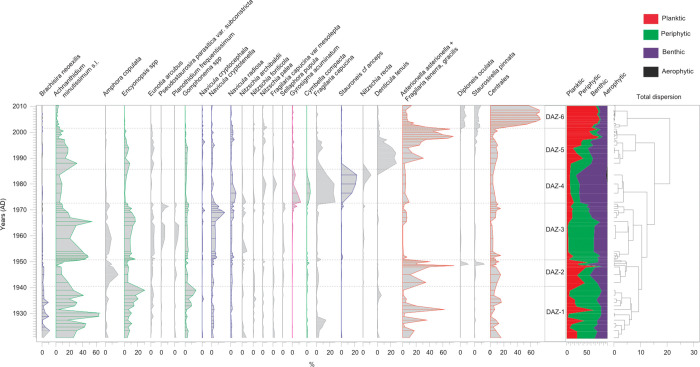
Downcore changes in the relative frequency of selected diatom taxa and the life forms changes in gravity core SC-4 (significant diatom assemblage zones—DAZ as defined by CONISS and validated by the broken stick model [54] are also shown).